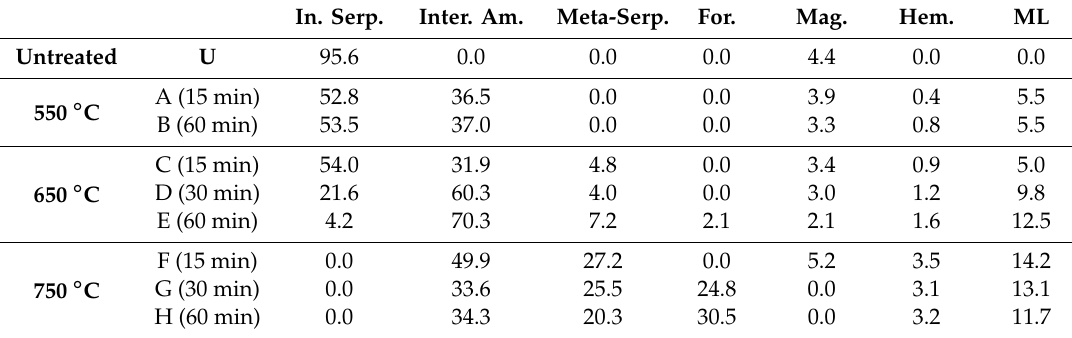
Table 6. Mineralogical compositions based on Rietveld refinements, expressed in grams per 100 g of starting material) at given temperature and residence times. In. Serp: Initial serpentine, Inter. Am.: Intermediate amorphous components, Meta-serp.: Meta-serpentine, For.: forsterite, Mag: magnetite, Hem: hematite and ML: Mass loss. In. Serp. Inter. Am. Meta-Serp. For. Mag.